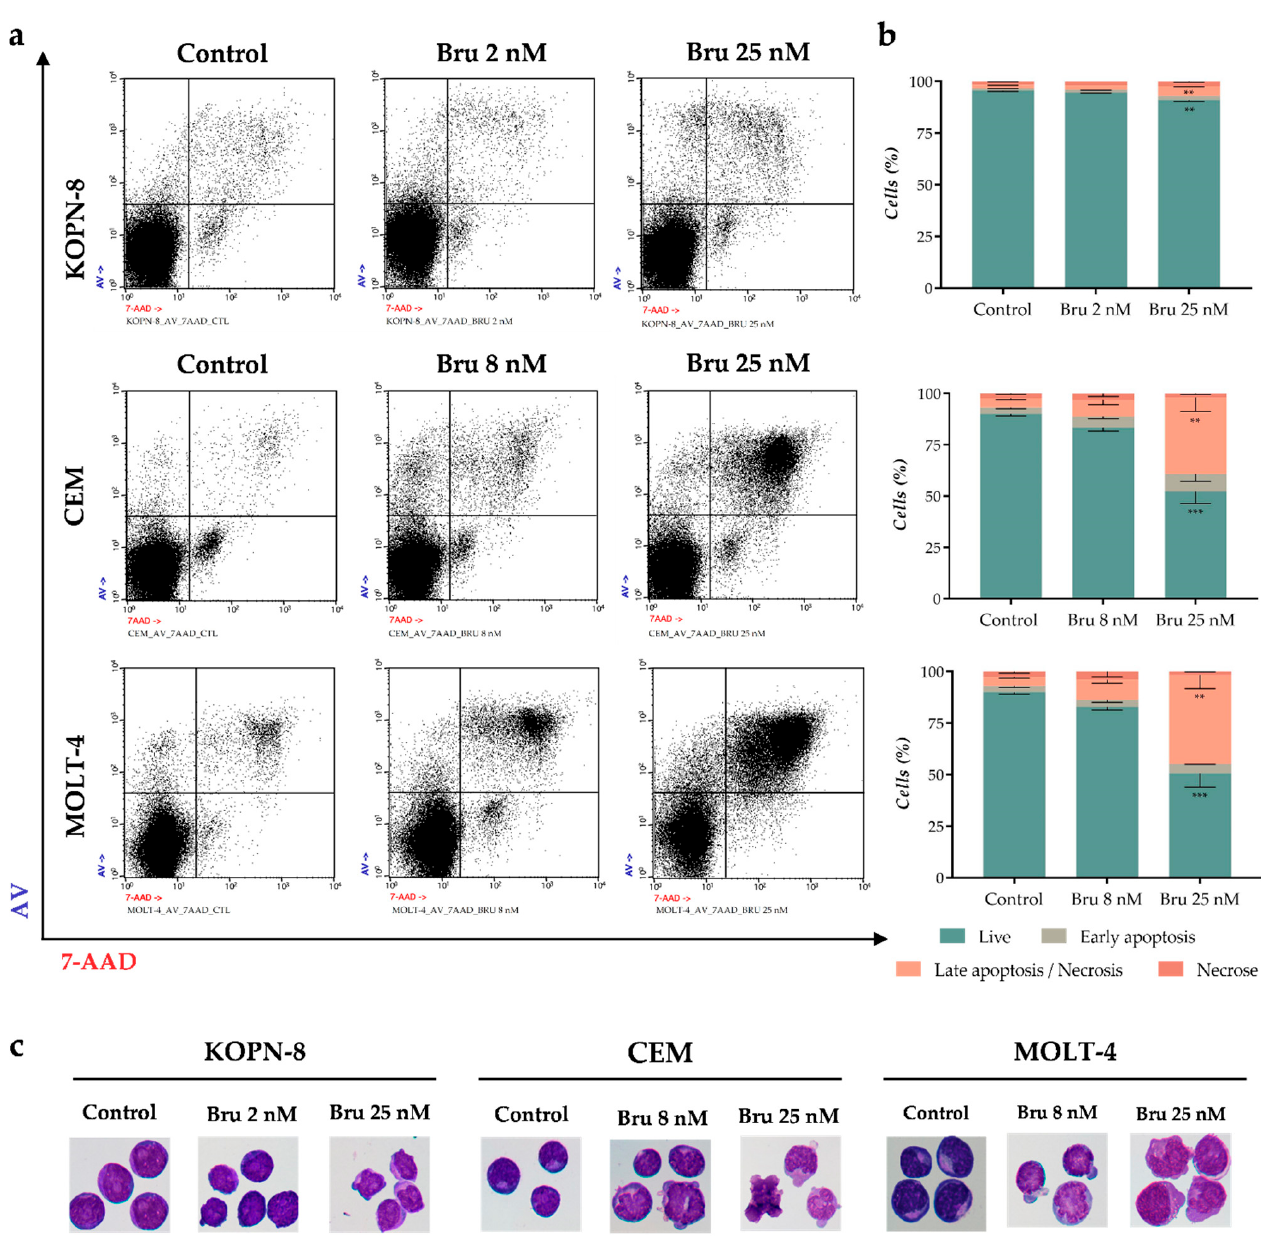
Figure 4. Analysis of cell death induced by brusatol in acute lymphoblastic leukemia cell lines. Cell death was detected by annexin V/ 7-AAD double staining and analyzed by flow cytometry (FC) ( a ) and ( b ) and by optical microscopy ( c ). ( a ) Representative dot plots from cell death analysis by FC; ( b ) Cell death analysis data are expressed in percentage (%) of live, early apoptotic, late apoptotic/necrotic, and necrotic cells. The data represent the mean ± SEM of at least 3 independent determinations; ( c ) Cell morphology was observed by light microscopy using May-Grünwald-Giemsa staining (amplification 500 × ). ** p < 0.01, *** p < 0.001 comparing with untreated cells (control). AV, annexin V; Bru, brusatol.